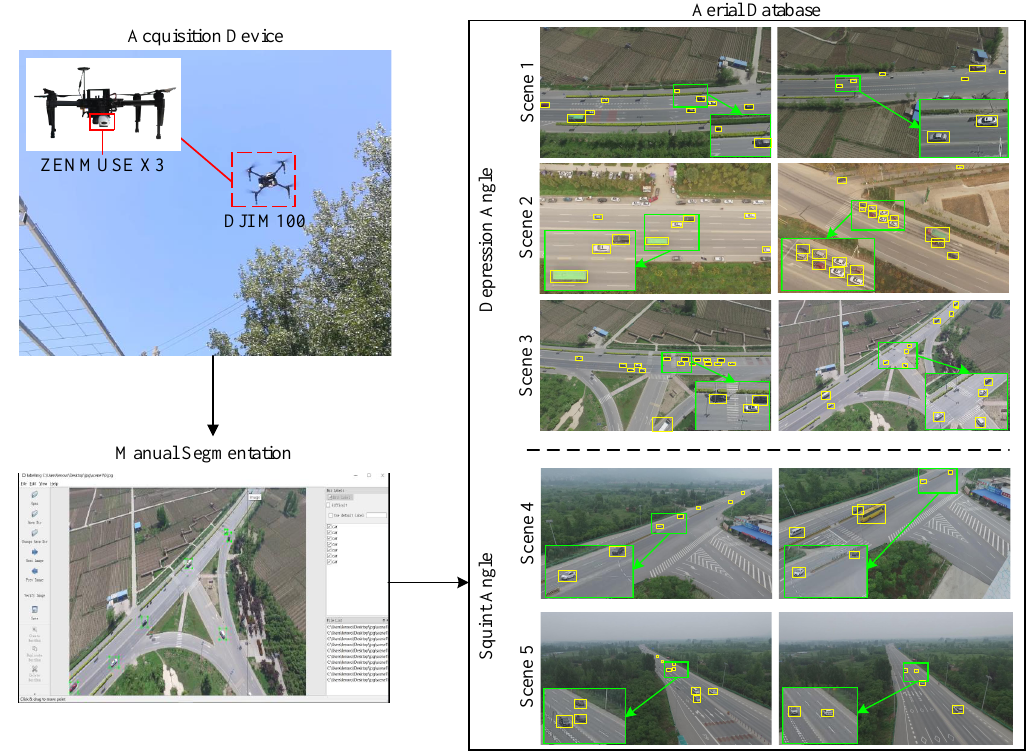
Figure 7. Experimental installation of aerial database. All test data were collected by DJI M100 with a ZENMUSE X3 camera (Shenzhen, China). We manually segmented its ground truth with the LabelImg tool. The right part of the figure shows some typical frames of the aerial video database. The yellow box is the ground truth of each